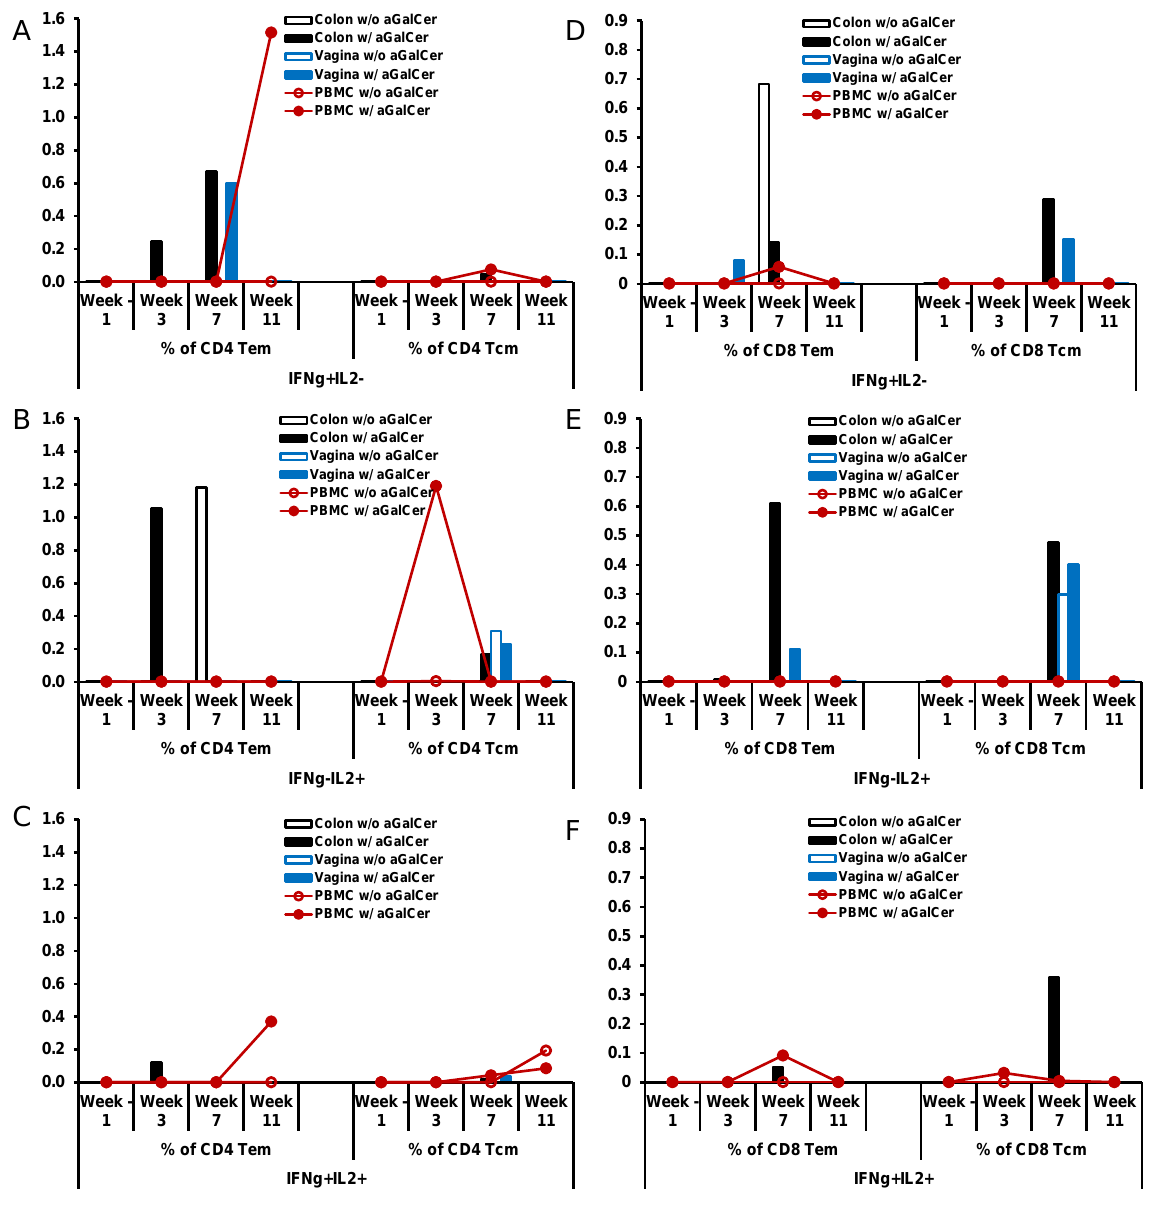
Figure 7. Enhancement of antigen-specific memory subsets of CD4 and CD8 T cells responses after sublingual immunization with HD-Ad HIV envelope in the presence of α-GalCer adjuvant: Single cell suspensions prepared from biopsy tissues of colon and vagina along with PBMC from single rhesus monkey immunized by the sublingual route with the HD-Ad vector encoding the HIV-1 envelope protein (10 11 vp) alone or along with α-GalCer (125 µg), open and closed symbols, respectively, were analyzed by flow cytometry for IFN-γ and/or IL-2 producing effector and central memory subsets (Tem and Tcm, respectively) of CD4 ( A – C ) and CD8 ( D – F ) T cells. Various tissues at different time points post immunization showing percentages of CD4 T cells and CD8 T cells producing IFN-γ alone (IFN-γ + IL2 − ; Figure 7A,D), IL-2 alone (IFN-γ − IL2 + ; Figure 7B,E) or both (IFN-γ + IL2 + ; Figure 7C,F). A